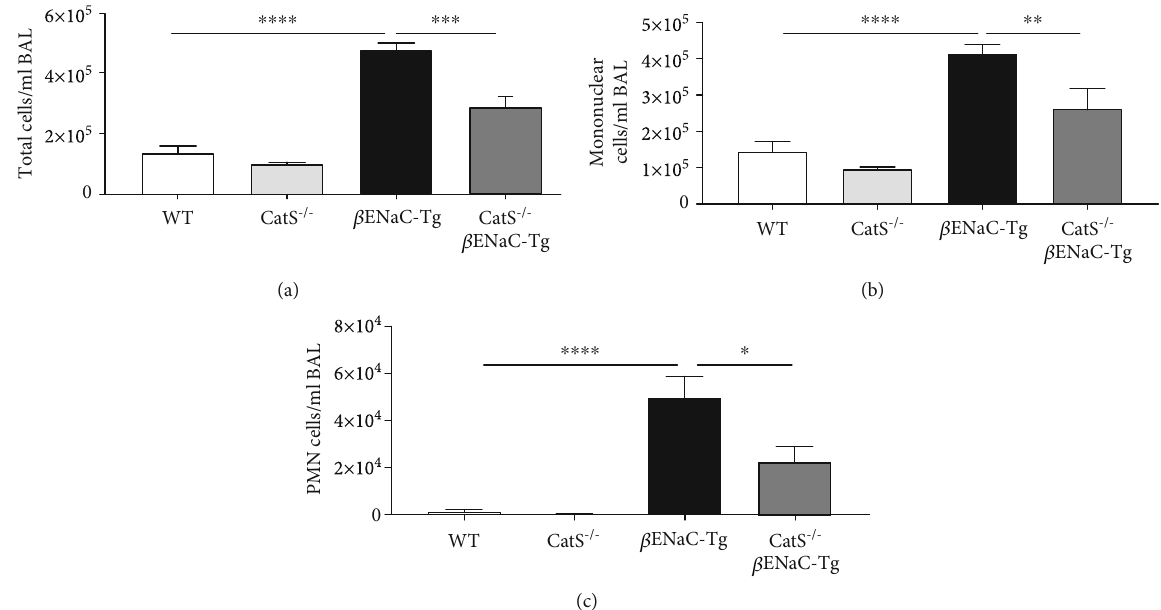
Figure 2: Cathepsin S knockdown from birth prevents airway in fl ammation in adult β ENaC-Tg mice. (a) Total cell, (b) mononuclear, and (c) polymorphonuclear (PMN) counts were quanti fi ed in BAL fl uid from 6-week-old WT, CatS -/- , β ENaC-Tg, and CatS -/- β ENaC-Tg mice ( n = 5 ‐ 12 per group). ∗ P < 0 : 05 , ∗∗ P < 0 : 01 , ∗∗∗ P < 0 : 001 , ∗∗∗∗ P < 0 : 0001 (one-way ANOVA with Tukey ’ s multiple comparisons test).